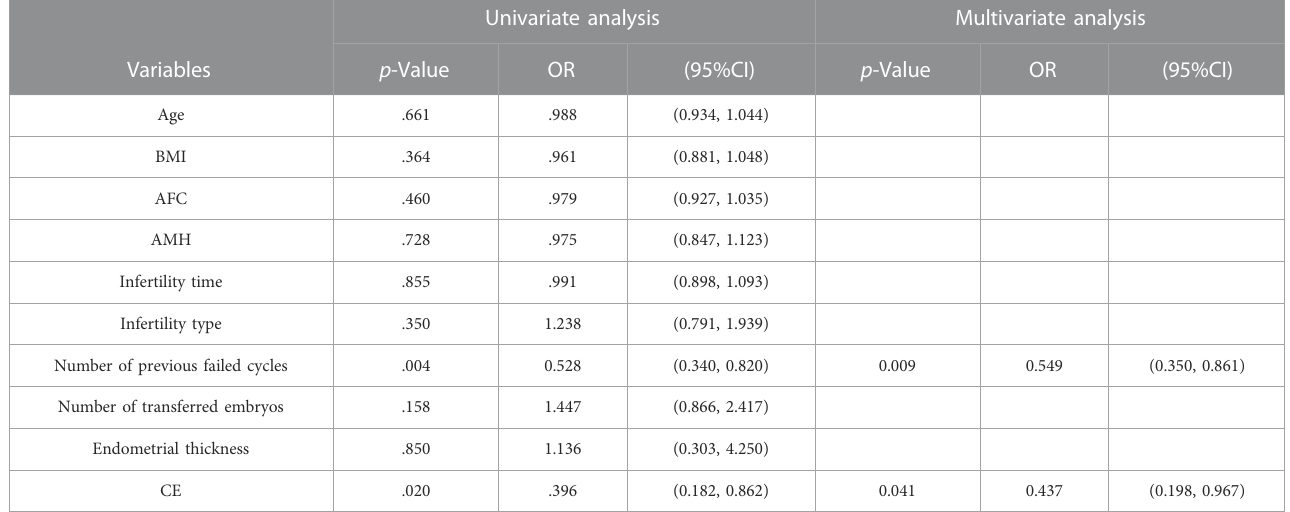
TABLE 4 Logistic regression analysis of factors affecting the live birth rate. Univariate analysis Multivariate